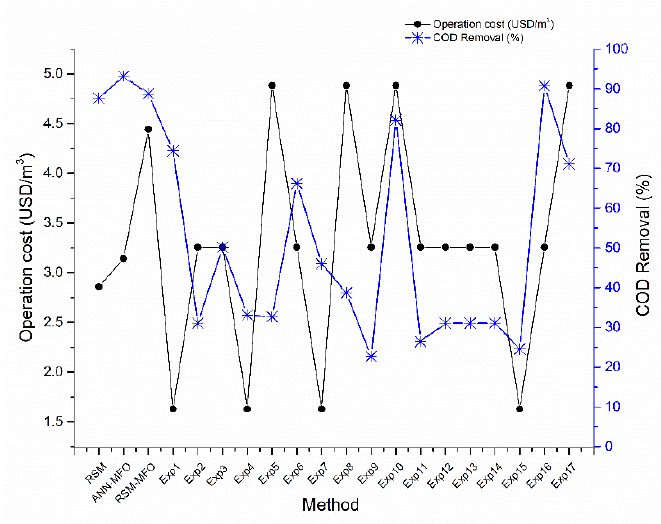
Figure 5. Operational cost in USD / m 3 and COD removal percentage for RSM, ANN-MFO, RSM-MFO and the 17 laboratory experiments.